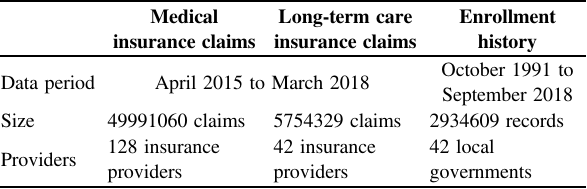
Table 2 Dataset used in this